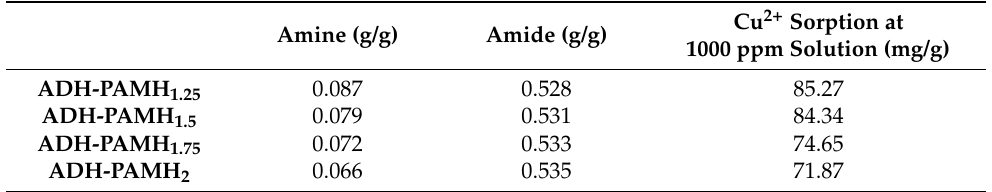
Table 2. Amine, amide compositions, and Cu 2+ sorption amount at 1000 ppm Cu 2+ solution of ADH-PAMH x .